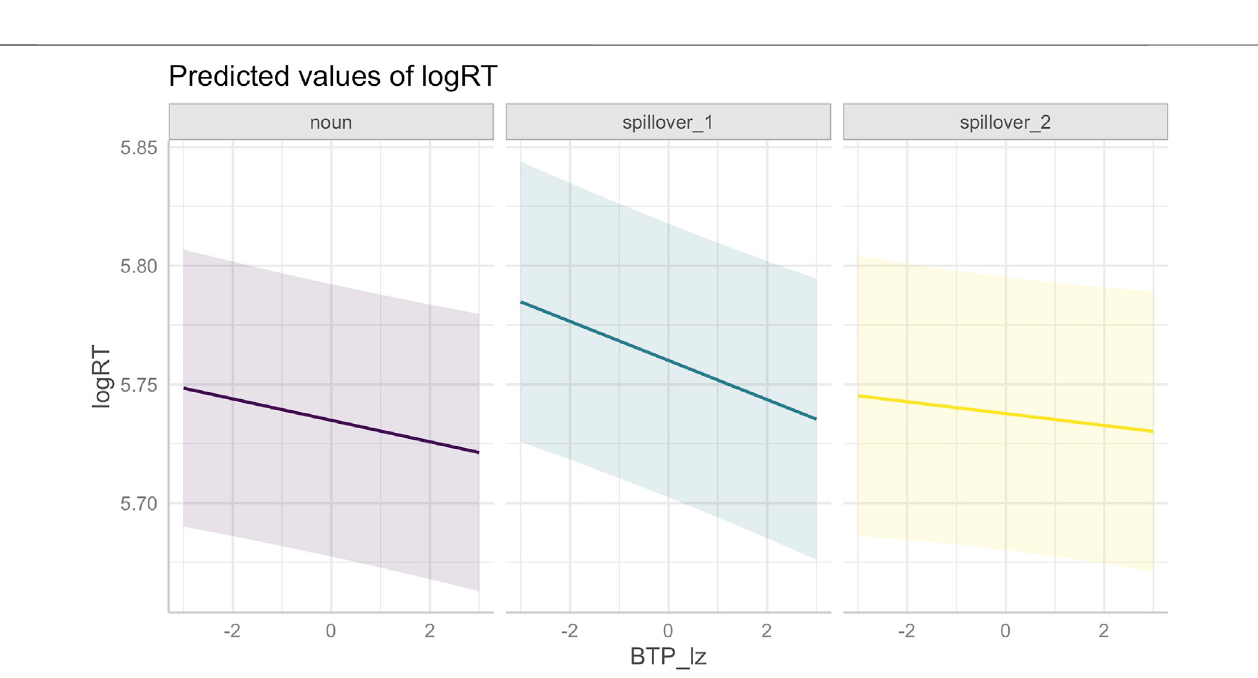
FIGURE 11 | Interaction between (log-transformed, z-scored) backward transition probability and position in the sentence (noun in associated modi fi er-noun bigram, fi rst and second spillover words).